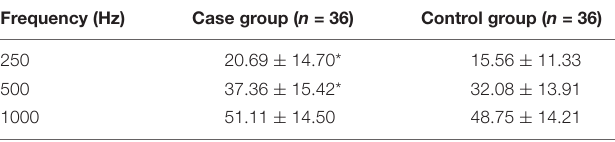
TABLE 3 | BC thresholds of case group and control group.